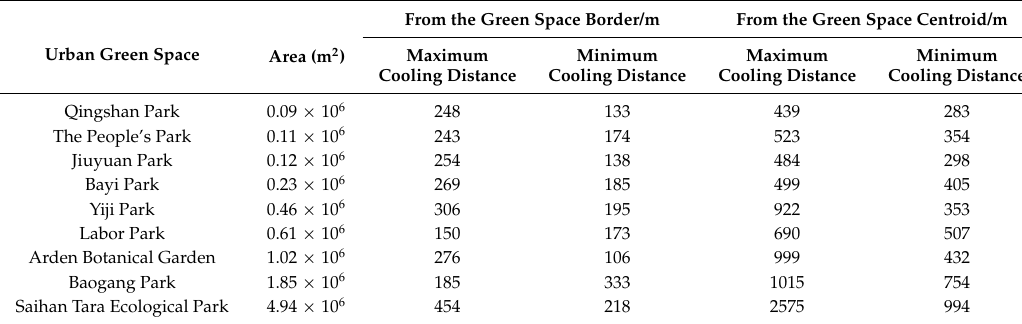
Table 3. The selected urban green space cooling distance.